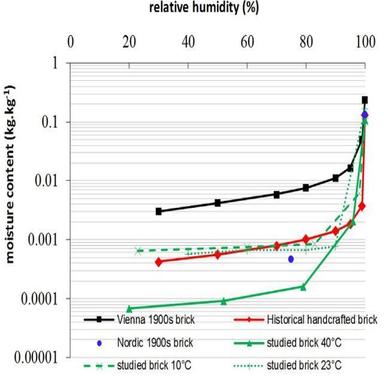
Main adsorption isotherms of different historical clay bricks.